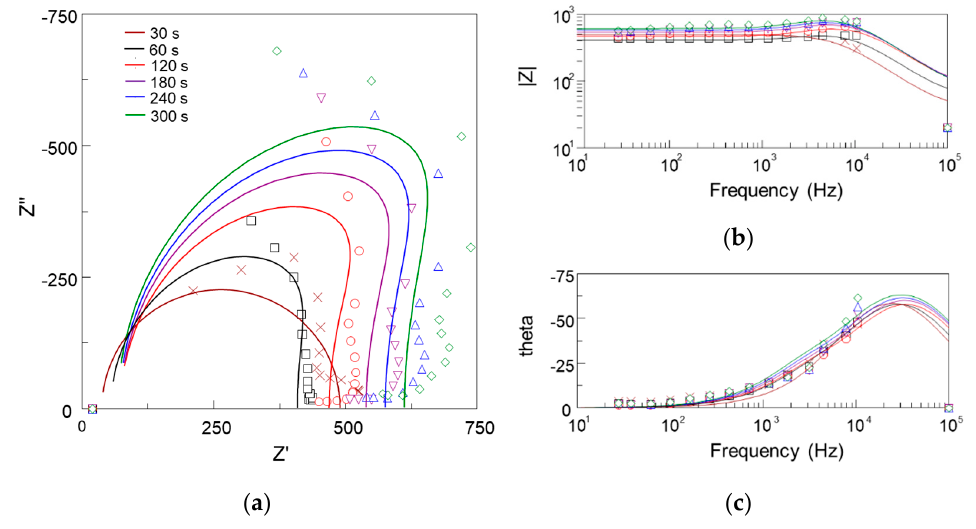
Figure 7. In situ impedance spectra of the PEO process during formation of the coating on Ti with the experimental data and fit results: ( a ) complex plot; ( b ) Bode plot for the impedance modulus; ( c ) Bode plot for the impedance phase angle.